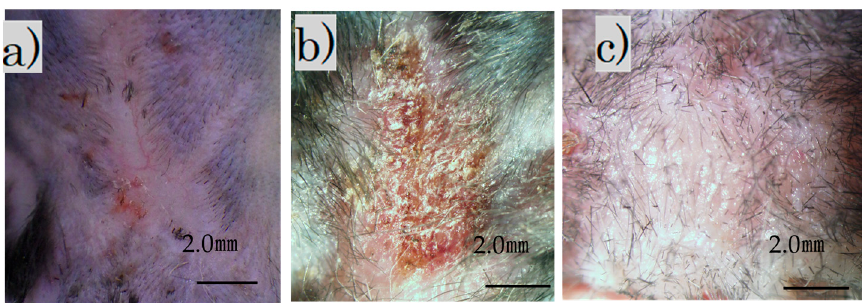
Figure 2. Images of treated and untreated scars: ( a ) mature scar at 2 months; ( b ) scar immediately after irradiation; ( c ) irradiation scar after 4 weeks (scale bar 2 mm).